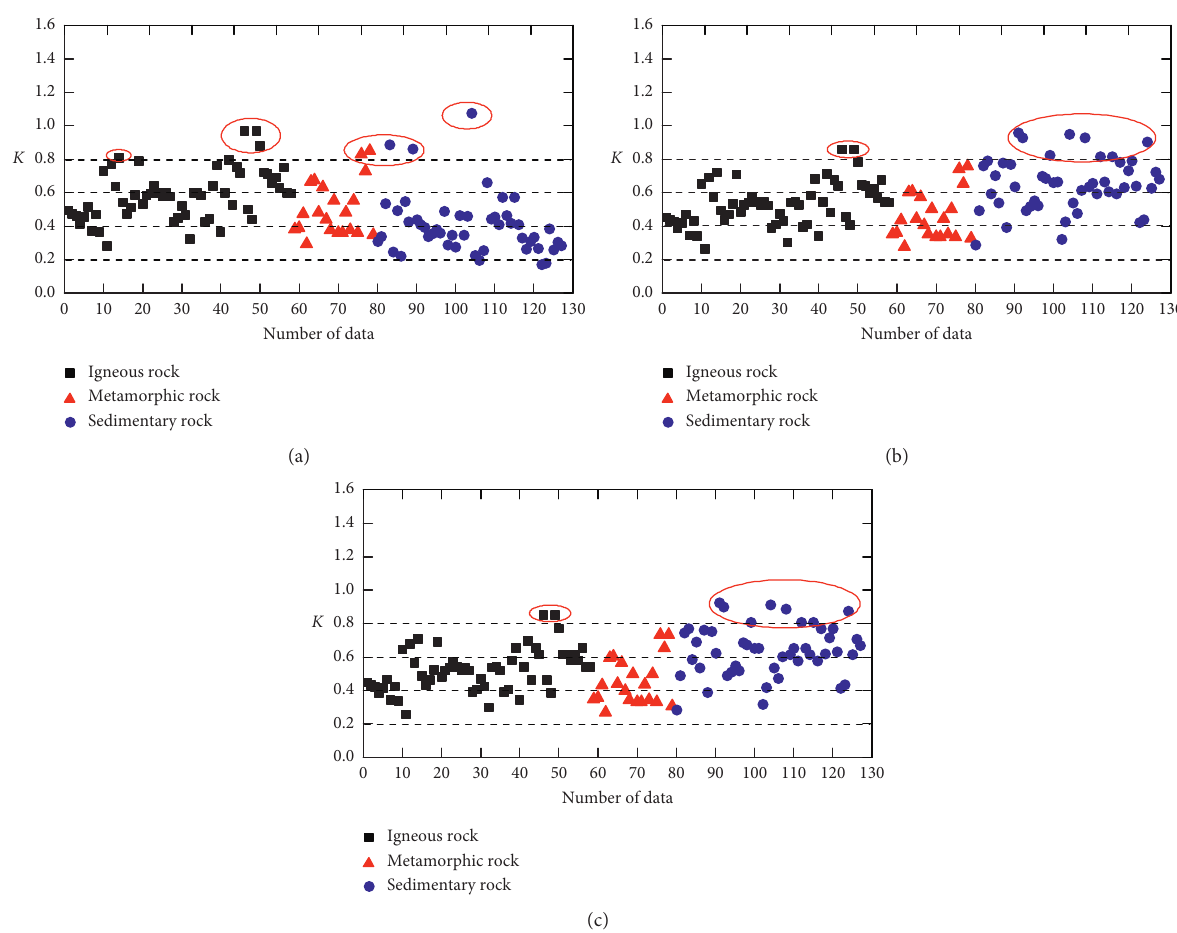
Figure 7: Prediction of K value for igneous, metamorphic, and sedimentary rocks using (a) method 1, (b) method 2, and (c) method 3. Table 4: Percentage of K value range distribution of different rock types under three prediction methods.